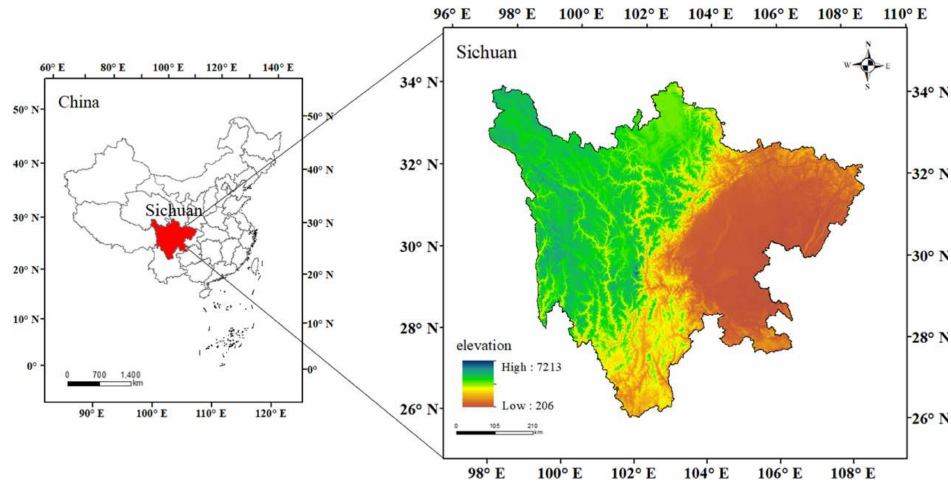
Figure 1. Geographical location of the study